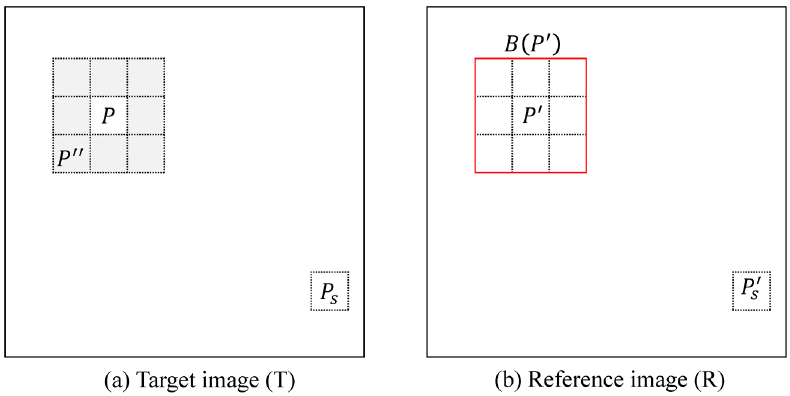
Figure 4. Sketch map of the similar pixels. ( a ) Target image T , in which P is a cloud pixel, P (cid:48)(cid:48) (gray-marked pixel) is the spatial non-cloud pixel of first order adjacency to P , P s is a candidate similar pixel of P ; ( b ) Reference image R , in which P (cid:48) is non-cloud pixel in the same position relative to P , B ( P (cid:48) ) is a 3 × 3 non-cloud block (red box) centered at P (cid:48) , P (cid:48) s is a candidate similar pixels of P (cid:48) .